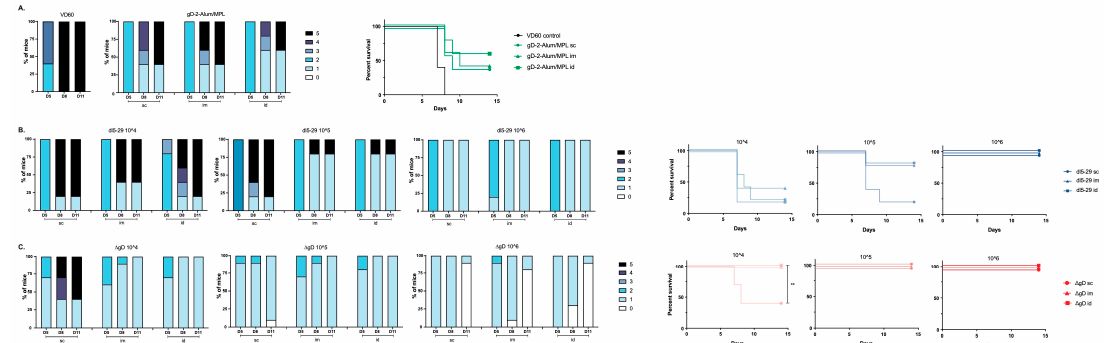
Figure 2. Di ff erences in immunogenicity based on vaccine dose and route translate to di ff erences in protection. Female C57BL / 6 mice were vaccinated twice, three weeks apart with 5 × 10 4 , 5 × 10 5 or 5 × 10 6 pfu / mouse of dl 5-29 or ∆ gD-2 or 5 µ g gD-2-Alum / MPL subcutaneously (sc), intramuscularly (im) or intradermally (id). Three weeks following the second vaccination, mice were challenged on the skin with 10 × LD90 HSV-2 (SD90). Disease scores over time (left panels) are shown for gD-2-Alum / MPL ( A ), dl 5-29 ( B ) and ∆ gD-2 ( C ). Percentage survival is shown in right panels. n = 5 mice per group for gD2 − Alum / MPL and dl 5-29 in a single experiment; n = 5 mice per group, two independent experiments for ∆ gD2 − . For survival curves, ** p < 0.01 by the Gehan–Breslow–Wilcoxon